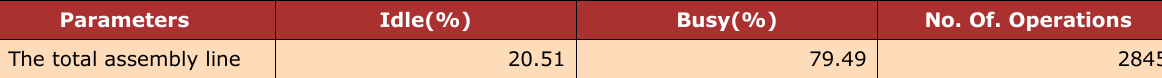
Table 6. The operation of engine assembly line after increasing